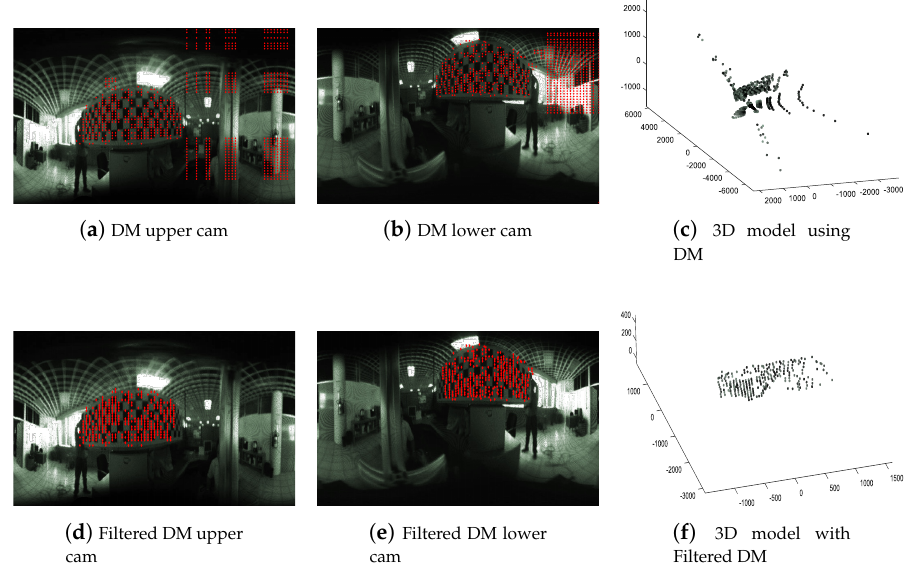
Figure 11. DeepMatching and filtered DeepMatching for 3D reconstruction of a known pattern.